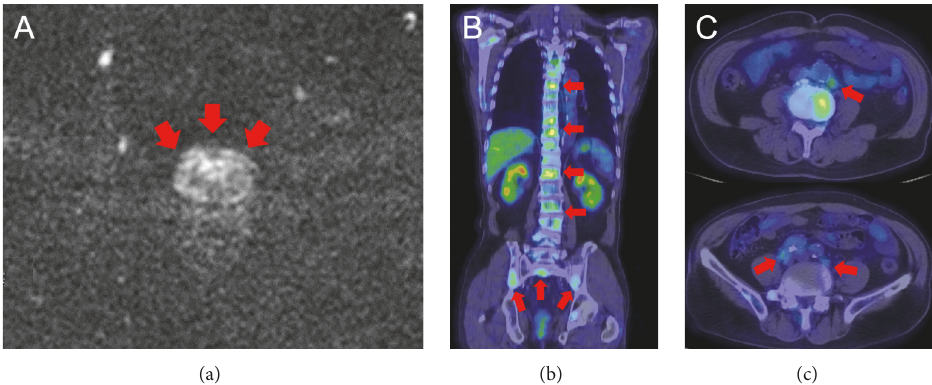
Figure 1: Image findings at initial diagnosis. Pelvic MRI (DWI) (a) showed extensive high signal of the prostate. FDG-PET/CT revealed multiple spine and pelvic bone (b) and para-aortic and pelvic lymph node metastases (c). MRI, magnetic resonance imaging; DWI, diffusion- weighted imaging; FDG-PET/CT, fluorodeoxyglucose-positron emission tomography/computed